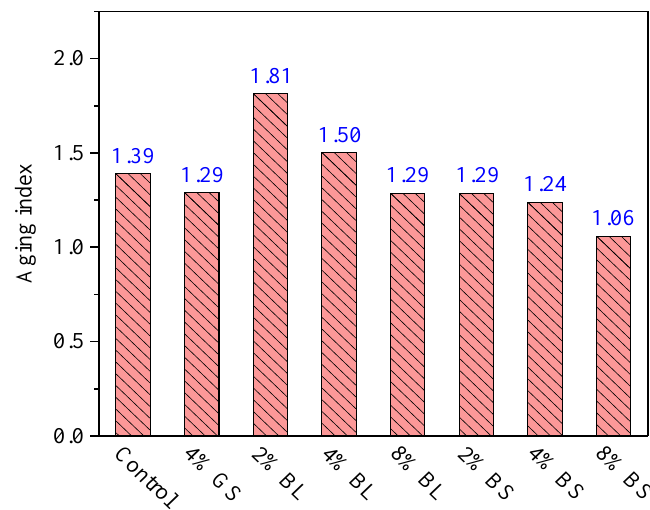
Figure 3. Aging indexes of control, graphite modified and bio-char modified asphalts.